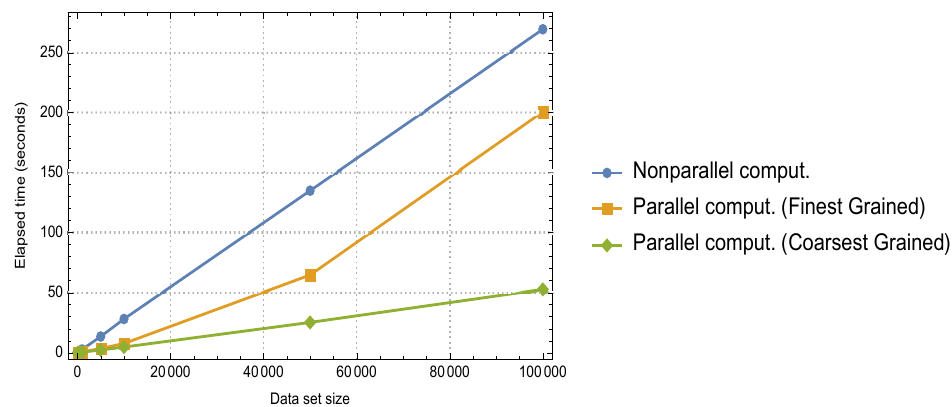
Figure 5. Time comparison for the classification by increasing the size of the lending portfolio in the absence and presence of parallelization.